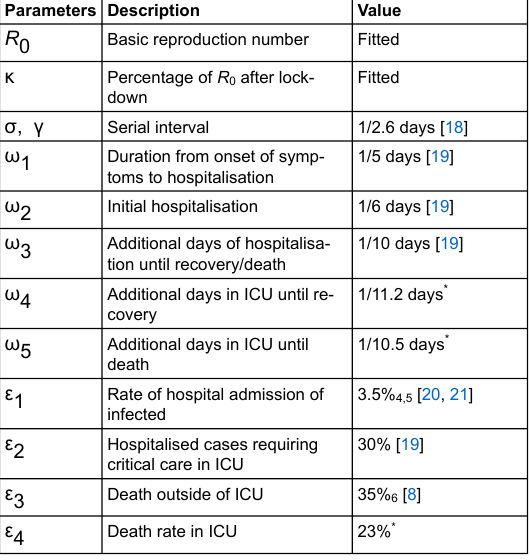
3 and the descriptions of compartments listed in table 2: